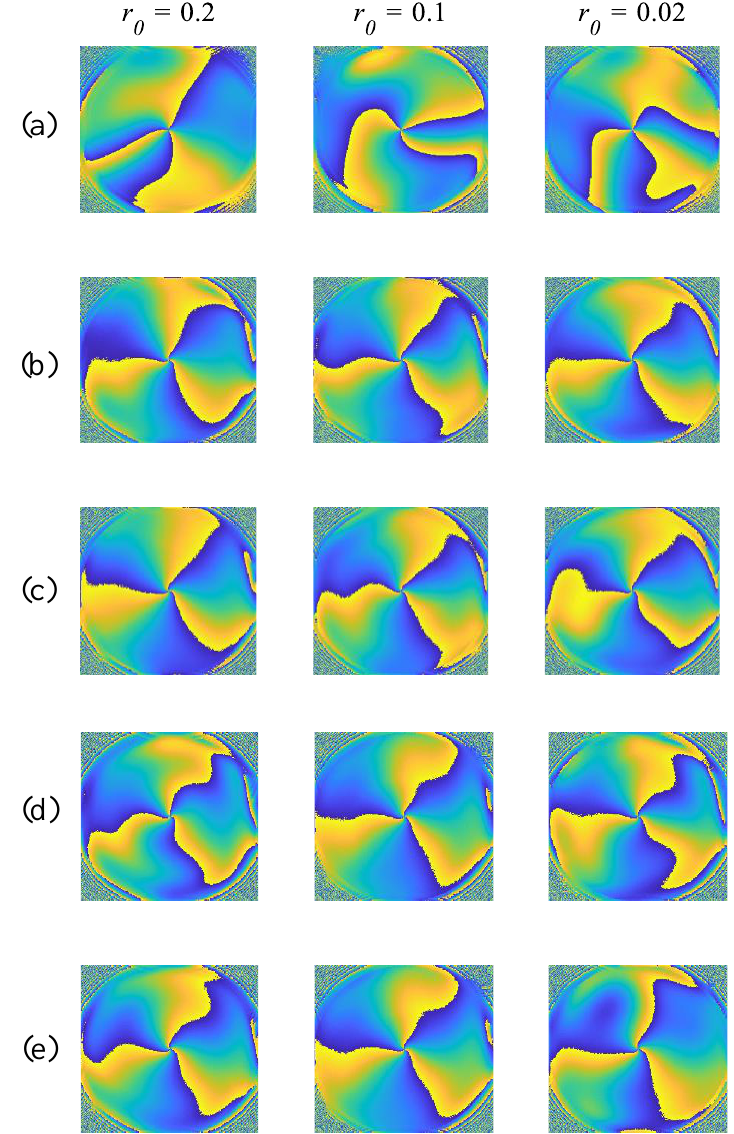
Figure 5. Comparison of the results of different algorithms for phase recovery: ( a ) before phase recovery; ( b ) MRWF algorithm; ( c ) WF algorithm; ( d ) TWF algorithm; ( e ) RWF algorithm.